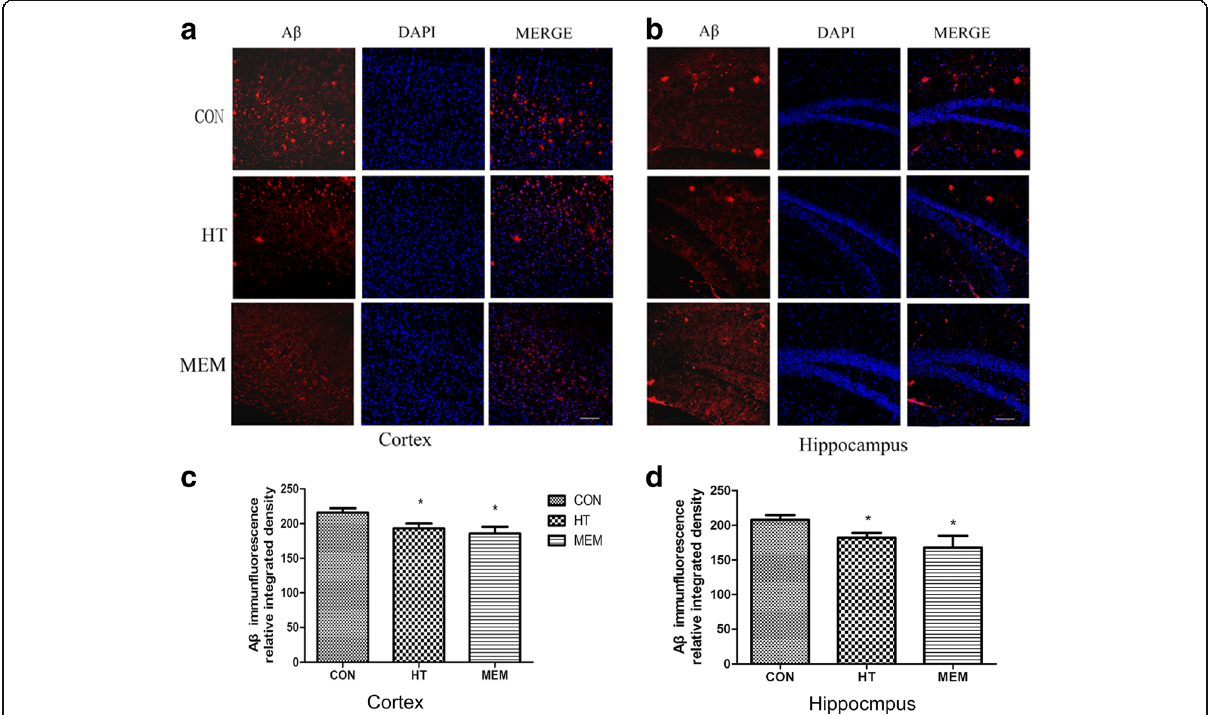
Fig. 6 HT decreased A β plaque deposition in the brains of APP/PS1 mice. Immunofluorescence for A β in the cortex ( a ) and hippocampus ( b ) of the APP/PS1 mice, with HT treatment and MEM treatment of APP/PS1 mice. Scale bar=100 μ m. The relative integrated density of A β in the cortex and hippocampus between different groups, HT-treated and MEM-treated groups better than the control group. ( c and d ), n =6 per group